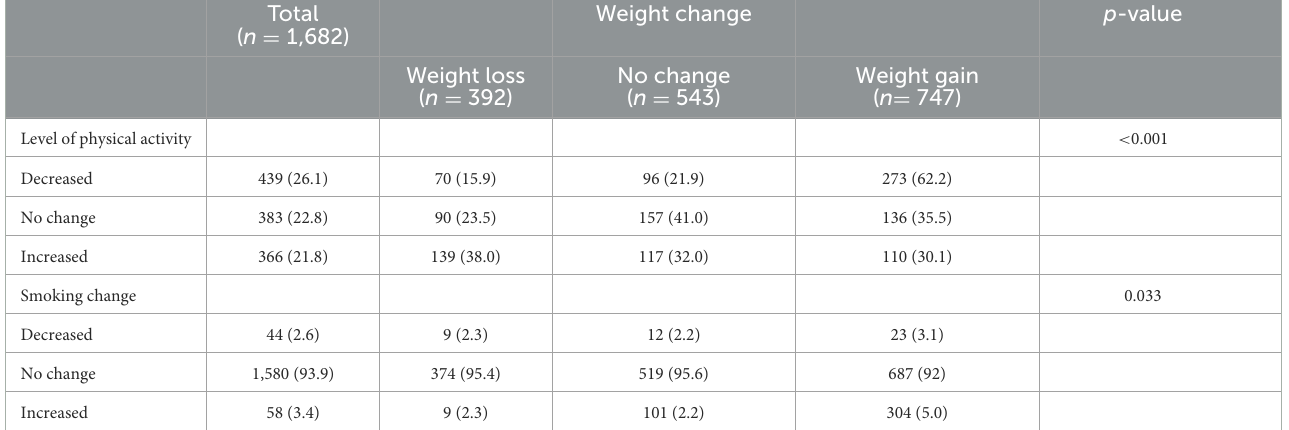
TABLE 4 Changes in the level of physical activity and smoking habits compared with weight changes during the COVID-19 lockdown in UAE ( n =